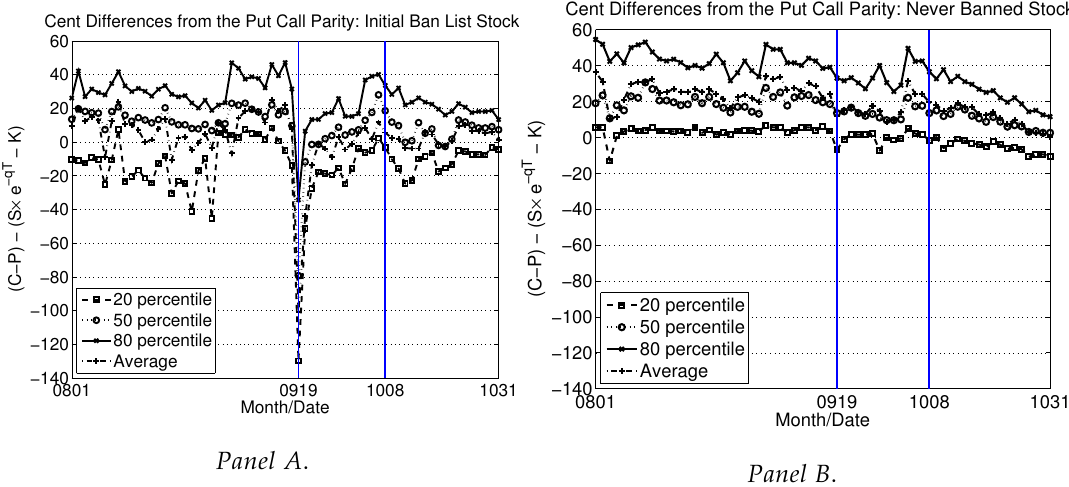
Figure 9. The figure reports the 20th, 50th and 80th percentile values and the average for the quantity ( C − P ) − ( S × e − qT − K ) in cents for: ( A ) the Initial Ban List stocks; and ( B ) Never Banned